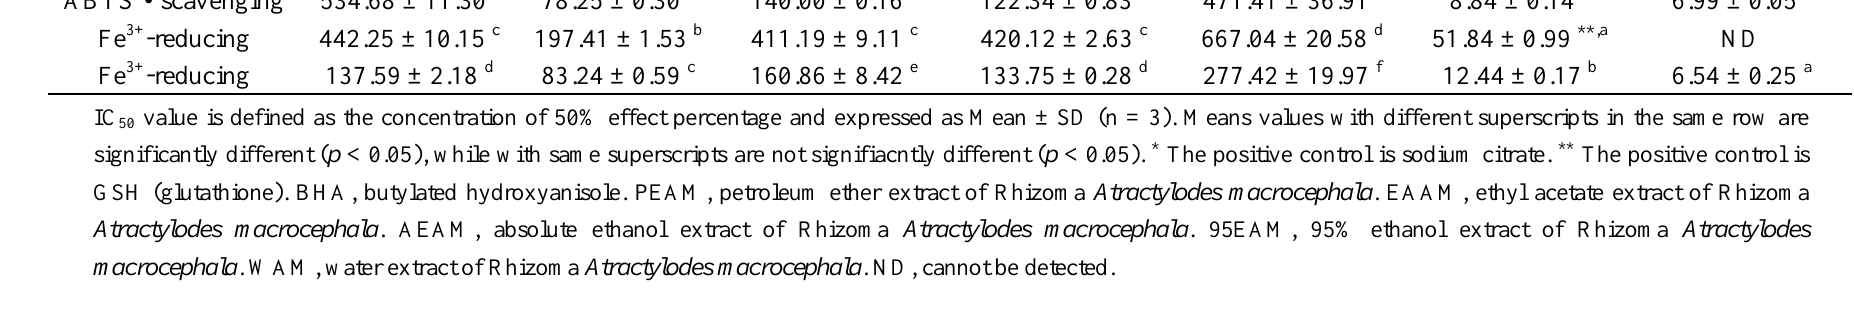
Table 2. The chemical contents of five extracts from Rhizoma Atractylodes macrocephala